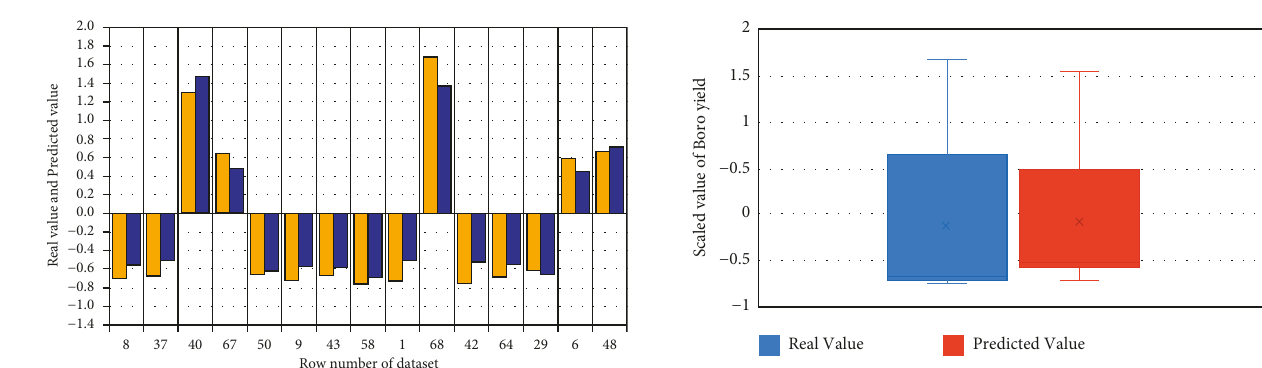
Figure 24: Comparison between real values and predicted values of Boro yield for XGBoost using box plot.